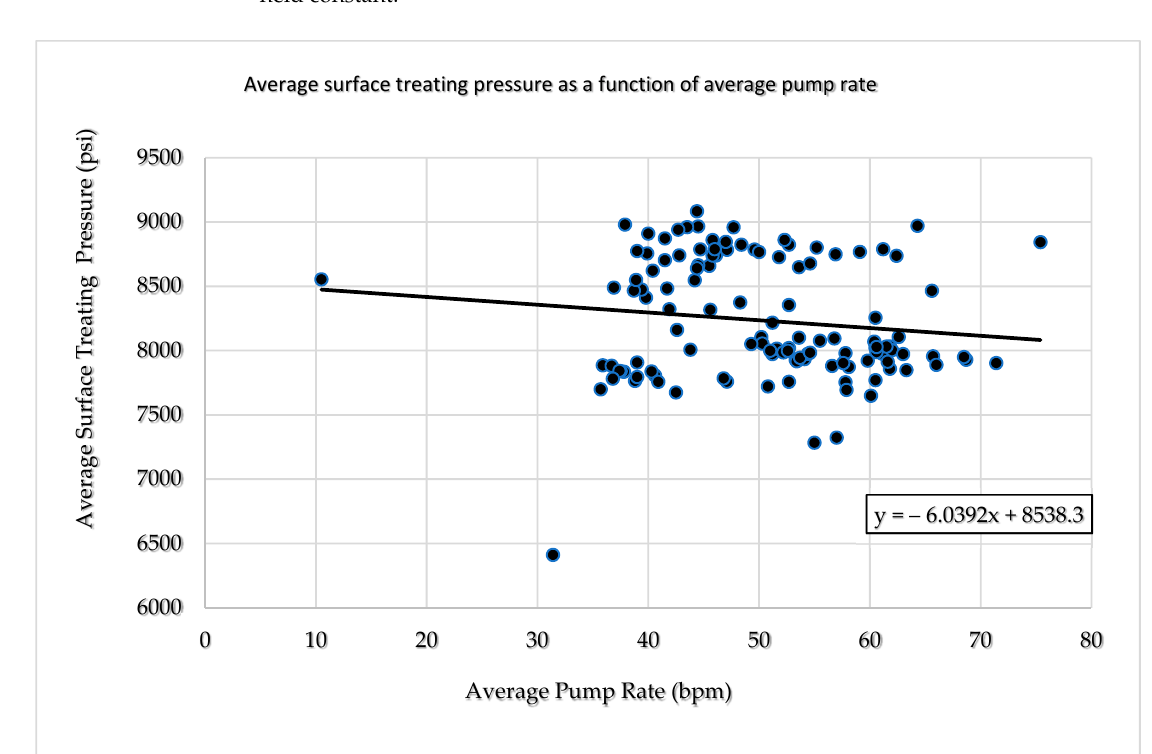
Figure 6. Bivariate regression model regressing average STP on average pump rate .